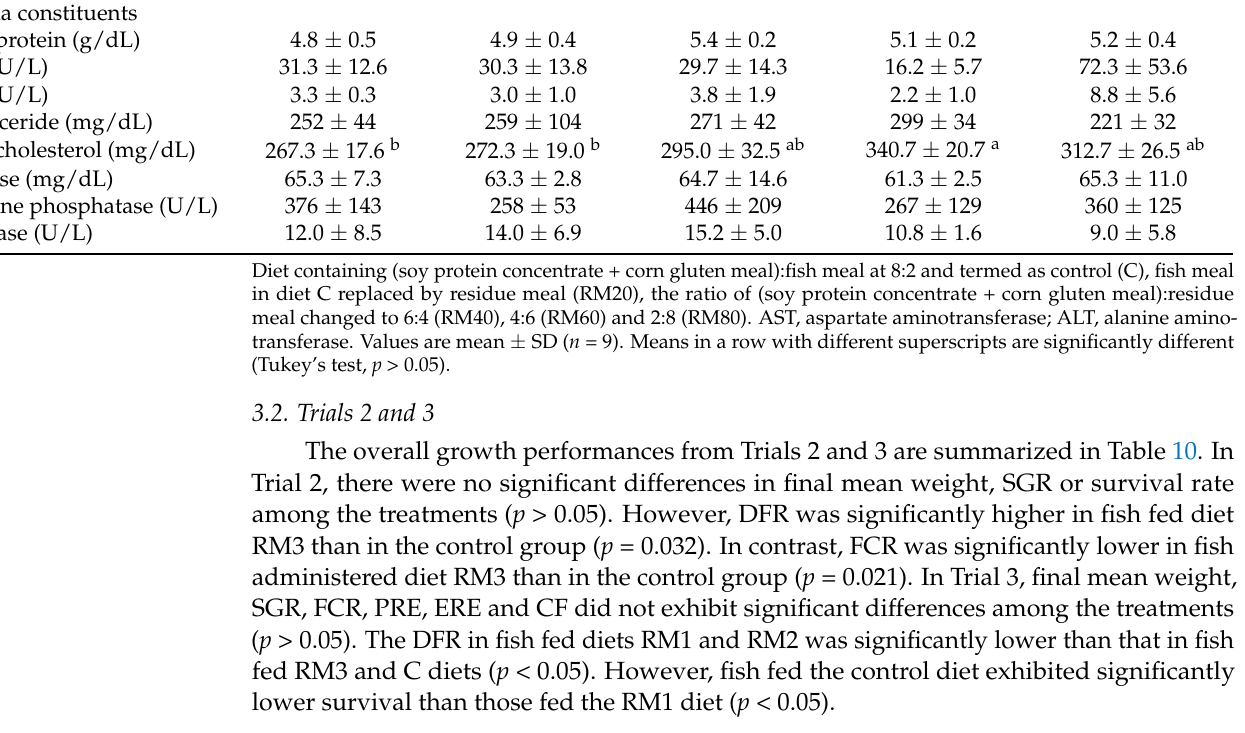
Table 10. Growth performance in red sea bream fed with experimental diets in Trials 2 and 3.